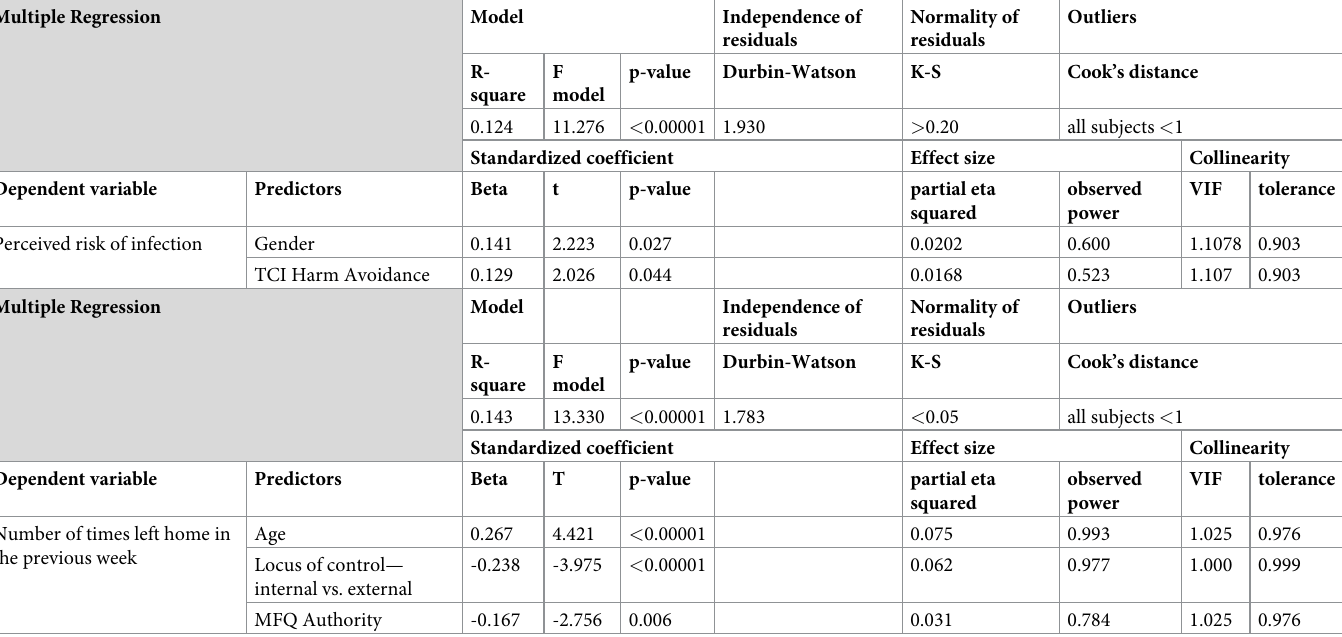
Table 5. Multiple regression